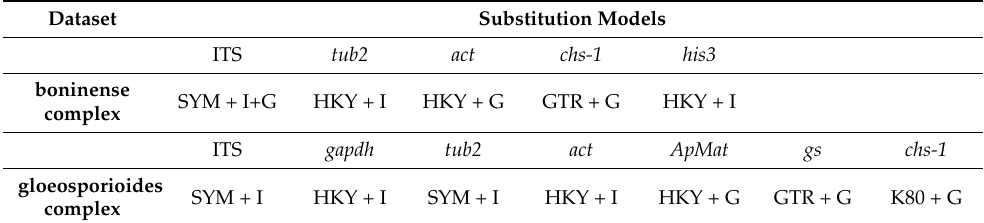
Table 1. Best-fit model for each gene locus selected by